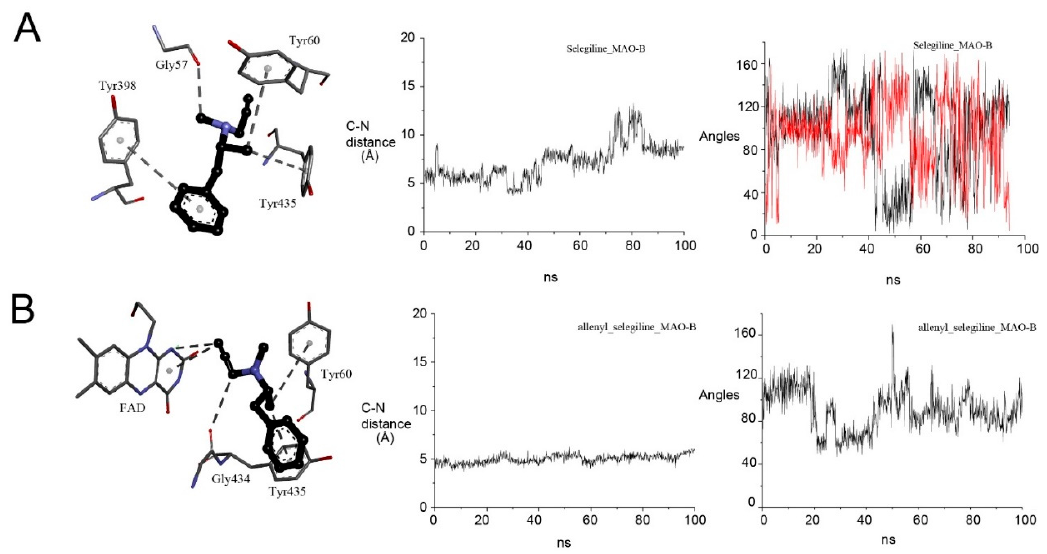
Figure 10. Orientation and movement of selegiline and its allenyl product in the active site of MAO-B. ( A ) Oxidized MAO-B with selegiline; ( B ) reduced MAO-B with the allenyl-imine product from selegiline oxidation. Left : interactions in the active site; Middle: atom plot distances of the α -carbon to N5 of FAD (top) or imine C-terminal to N5-FADH − (bottom); Right : the angle to FAD or FADH − .